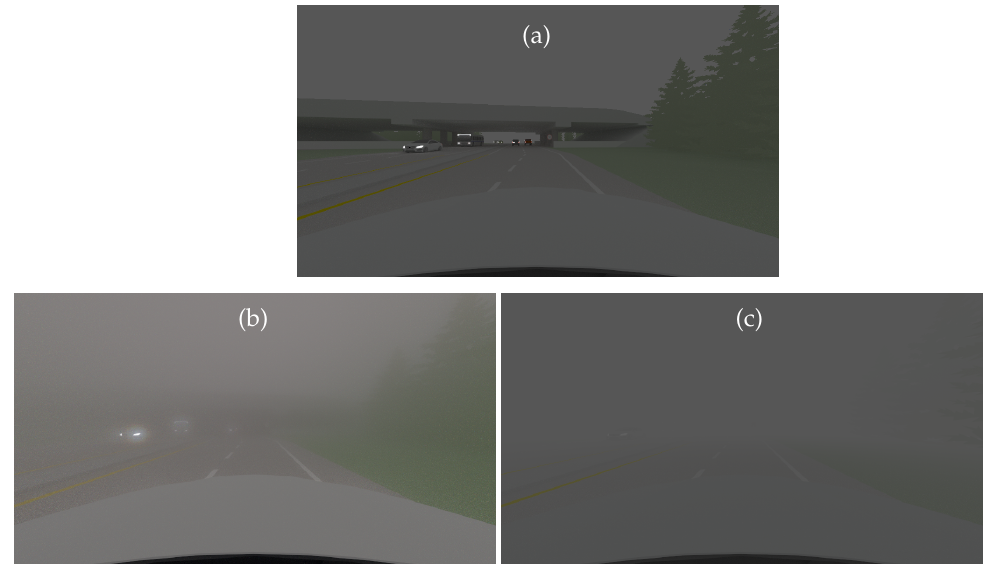
Figure 9. Simulated images for the extra-urban scene with the SWEET simulator without fog ( a ) and with fog (MOR = 20 m, ( b )) and with the Koschmieder model ( c ) in night